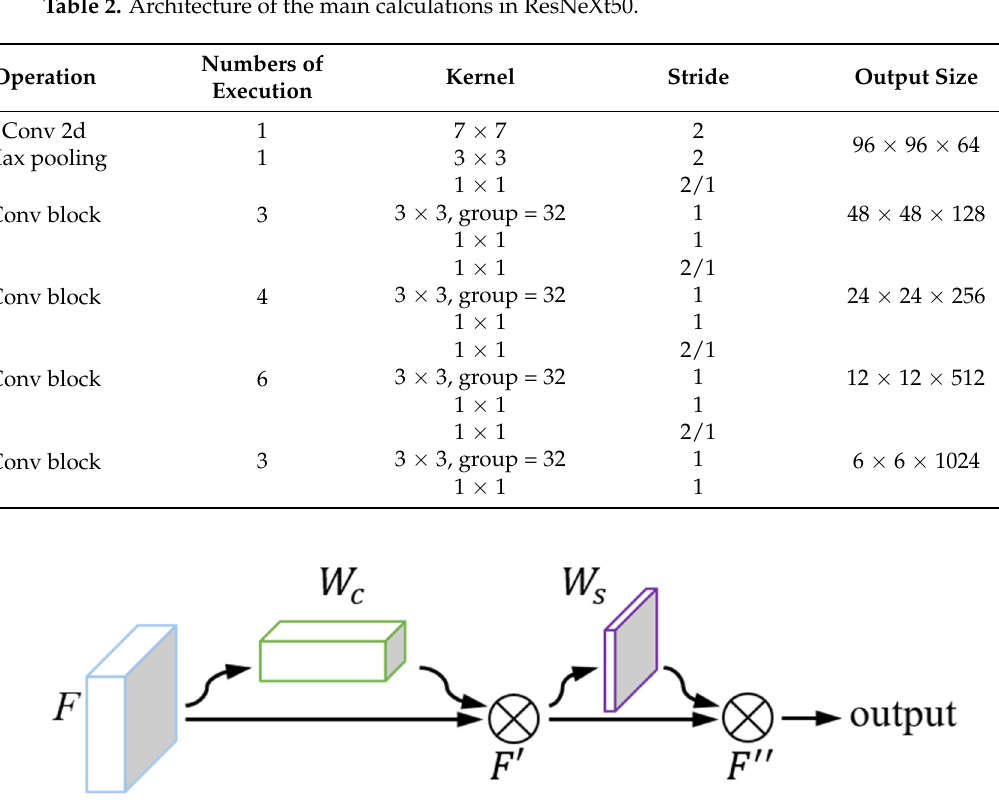
Figure 3. Structure schematic of the CBAM module. Note: w c is the channel attention weight, w s is the spatial attention weight, F is the original feature map, F’ is the channel weighted feature map, and F’’ is the spatial weighted feature map.